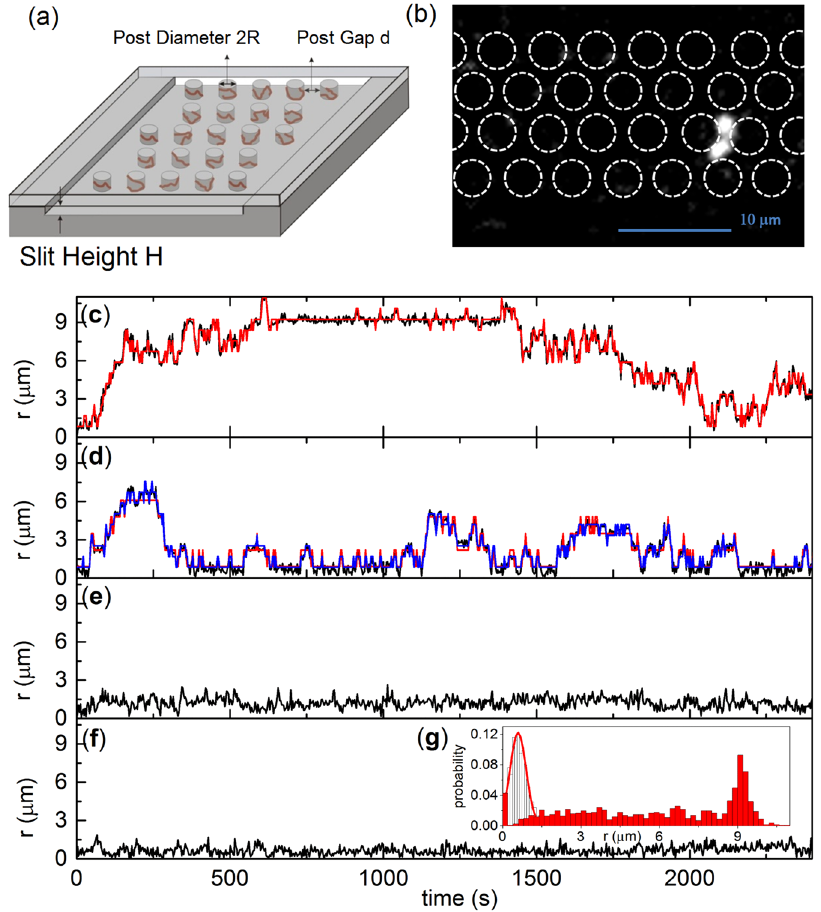
Figure 1. Nanoslit post array and DNA COM displacement trajectories. ( a ) Schematic of the nanoslit post array device. Red lines at post edges illustrate trapped DNA molecules. ( b ) A fluorescent DNA image in the d = 1.6 μ m post array with the dashed circles drawn to highlight the posts. The red diamond shows the unit cell for the hexagonal array. The COM displacement trajectories are shown for d = 1.6 μ m ( c ), 2.2 μ m ( d ), 3.0 μ m ( e ), and 3.6 μ m ( f ). Each trajectory represents a single DNA molecule. Experiments are black Flines and HMM fits are red (with step size 0.84) and blue lines (with step size 1.3). The histogram in ( g ) shows P ( r ) for d = 3.6 μ m with a bin size of 0.1 μ m and 800 counts, as well as the fit with a shifted-Gaussian function (red line). The red columns show P ( r ) for d = 1.6 μ m with a bin size of 0.2 μ m and 1000